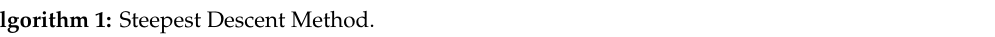
Algorithm 1: Steepest Descent